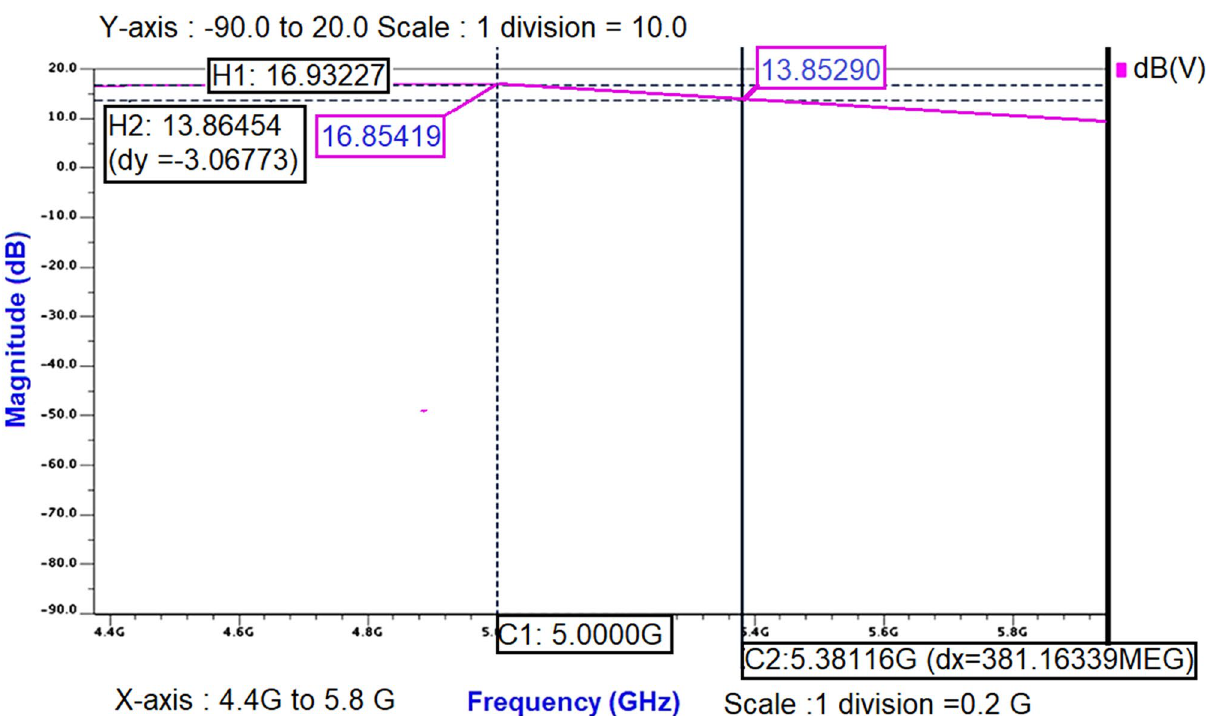
Figure 19. The small-signal gain obtained from AC analysis of Class-J